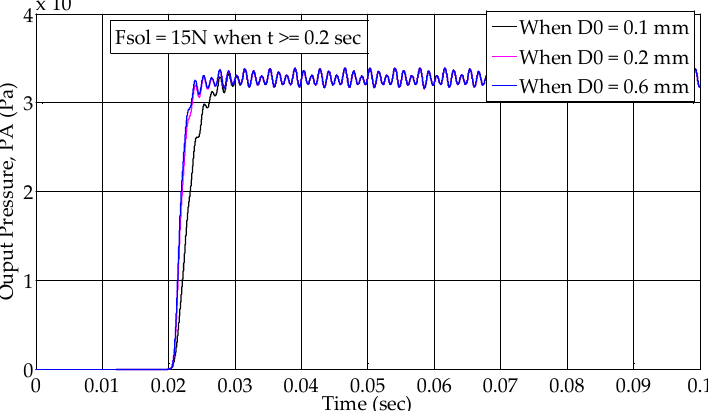
Figure 13. Steady-state output pressure for different values of orifice size and solenoid force.